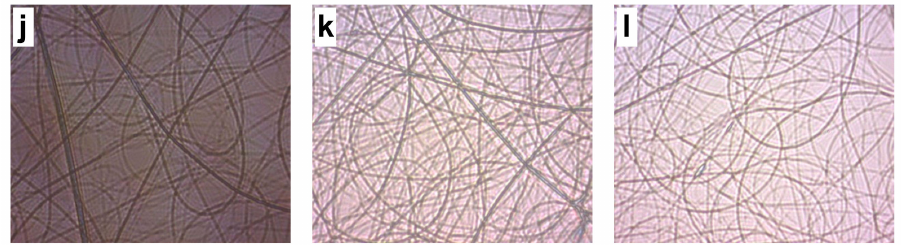
Figure 1. Micrographs of fibers produced by using a 2 wt % CS/8 wt % PVA solution (40 × resolution):